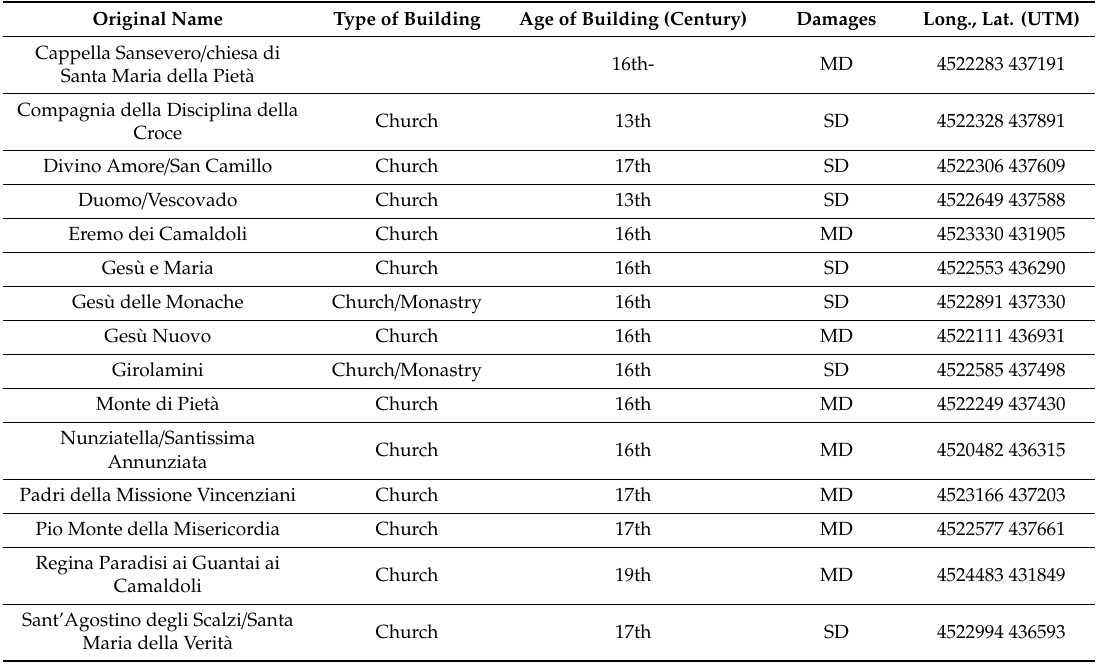
Table A6. The historical buildings of Naples damaged by the 1980 earthquake [5–7,14,56–58] and the estimated level of damage. (GD Great damage; SD Serious damage; MD Minor